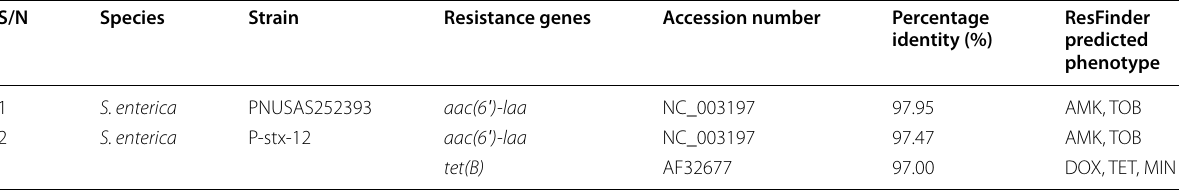
Table 2 ResFinder results for resistance genes of 2 strains of S. enterica S/N Species